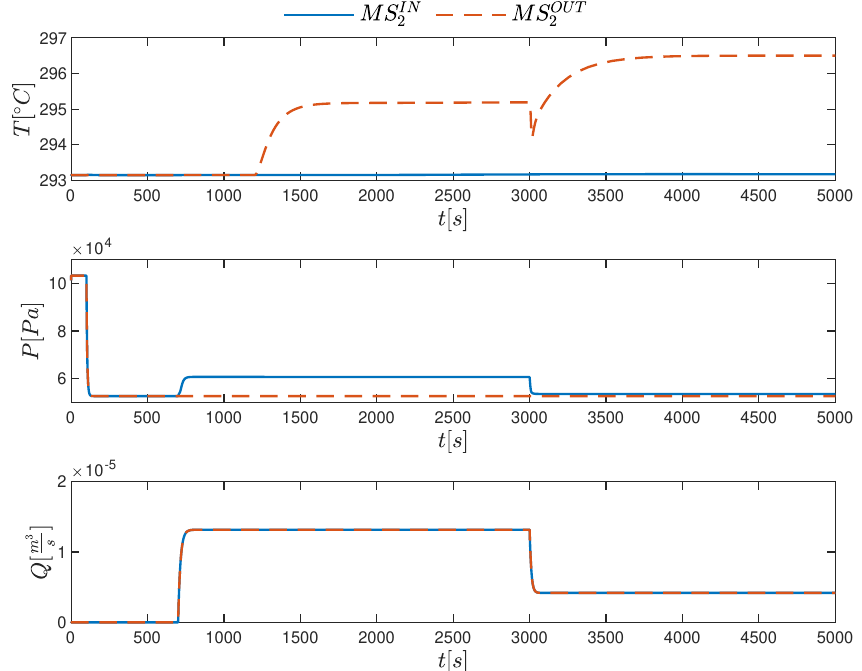
Figure 22. Temperature, pressure and volumetric flow change in the system during the simulation scenario. Measurements have been taken before the second section ( MS IN section ( MS OUT ). 2